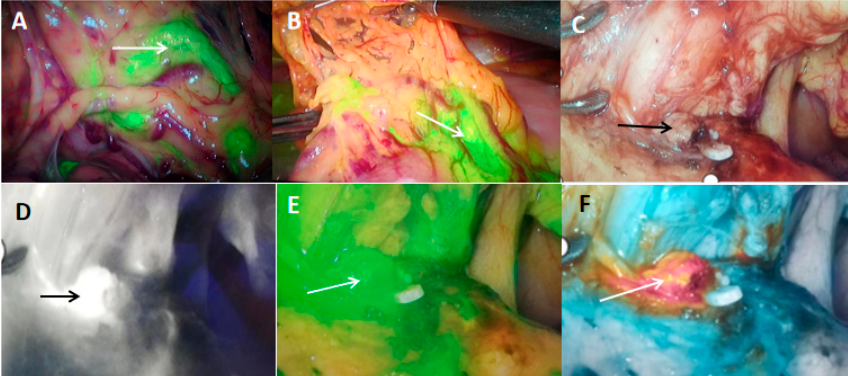
Figure 2. Indocyanine green (ICG) near-infrared imaging for tumor and lymph node localization in laparoscopic radical gastrectomy. ( A , B ) arrow refers to the metastatic lymph nodes; ( C – F ) are ICG near-infrared light imaging of the lymph nodes behind the pancreas head, showing conventional cold light imaging, black and white mode, green mode, and color fluorescence mode, respectively.